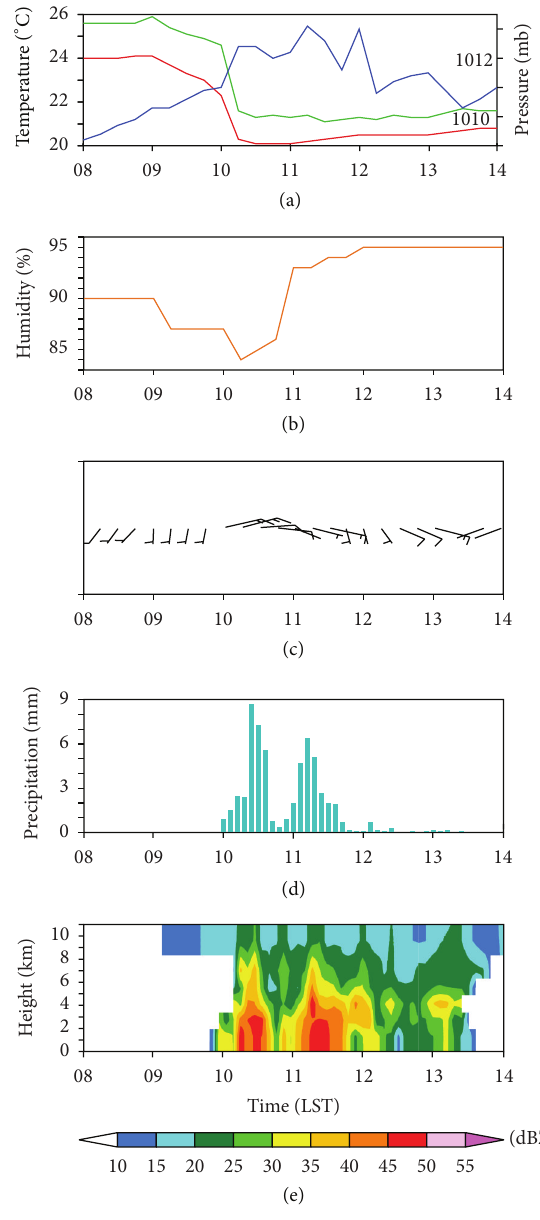
Figure 6: Time series of Zhuhai weather station temperature ( ∘ C, green line (a)), dew point ( ∘ C, red line (a)), pressure (mb, blue line (a)), relative humidity (%, yellow line (b)), and wind (m/s (c)) every 15min; precipitation every 6min (mm, bar graphs (d)) between 0800 and 1400 LST 24 April 2007. (e) Time-height cross-section of the reflectivity (dBZ) every 5.5 min at Zhuhai station observed by Guangzhou radar.